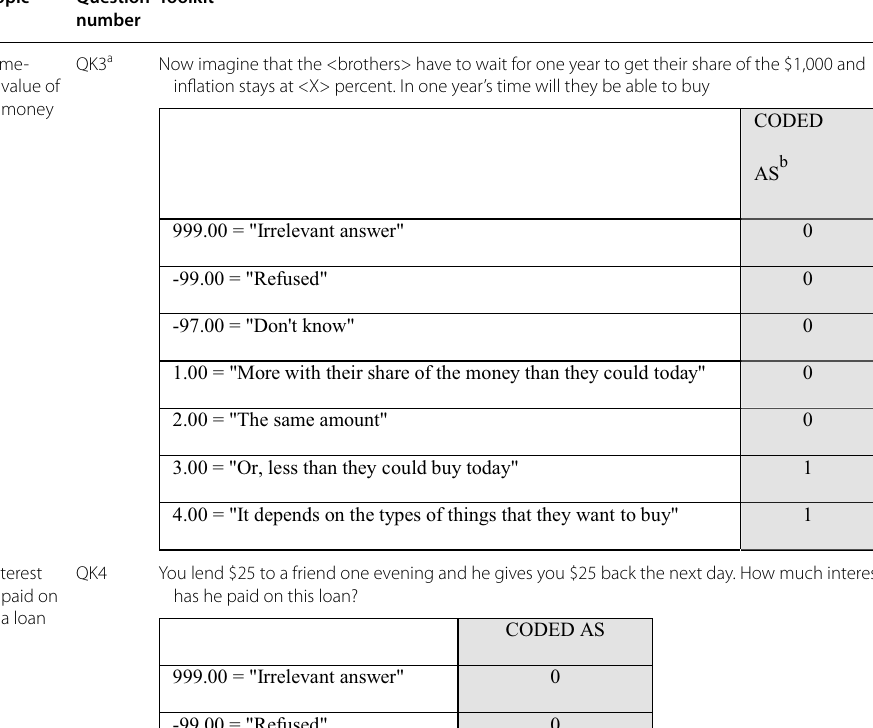
Table 10 Box 1: Extract from OECD (2016, p 84) on calculation of financial knowledge score. The financial knowledge score is computed as the number of correct responses to the financial knowledge questions, according to Table 1. It ranges between 0 and 7 (it is also possible to replicate the 8‑point score created in 2012 for countries using QK2 by adding the additional